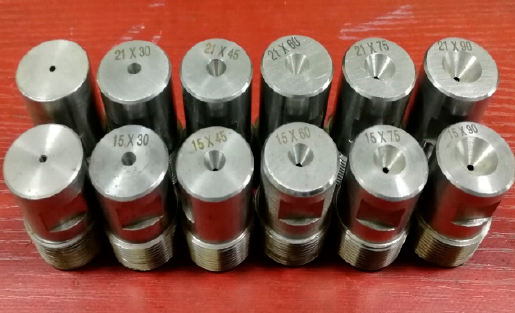
Figure 4. Picture of the tested organ-pipe nozzles.